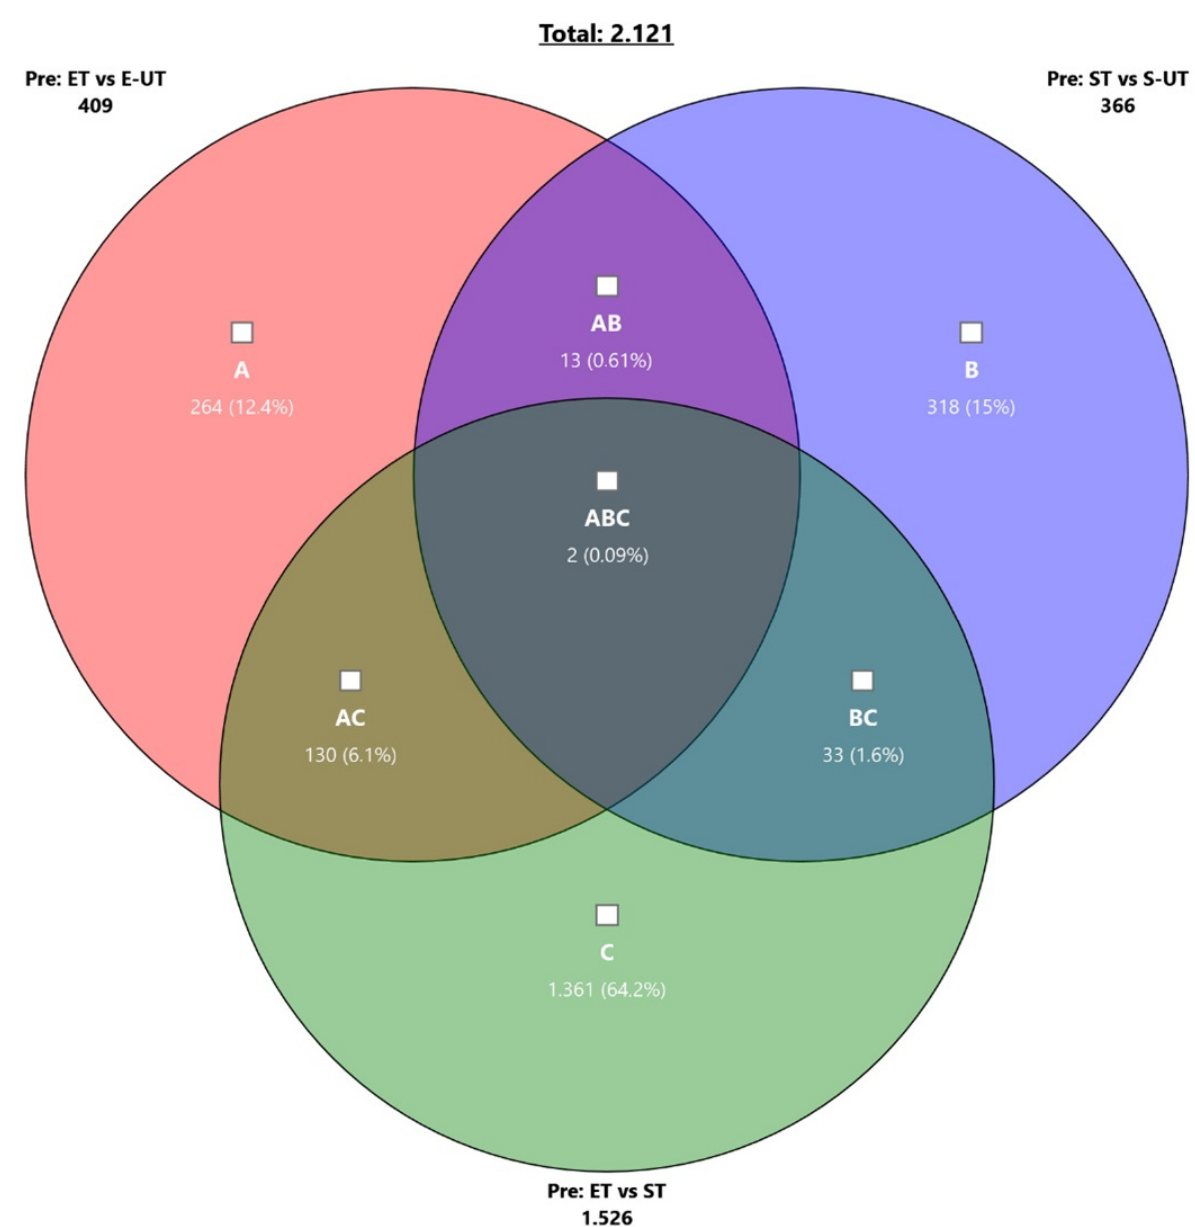
Figure 1. Venn-diagram of the differential expressed genes regarding the comparison of ET vs. E-UT (circle A ), ST vs. S-UT (circle B ) and ET vs. ST (circle C ) at baseline time point Pre. The overlap of ET/E-UT and ST/S-UT in differently expressed genes was only 0.61% (13 genes, AB ), whereas the highest overlap was seen between ET/E-UT and ST with 6.1% (130 genes, AC ).